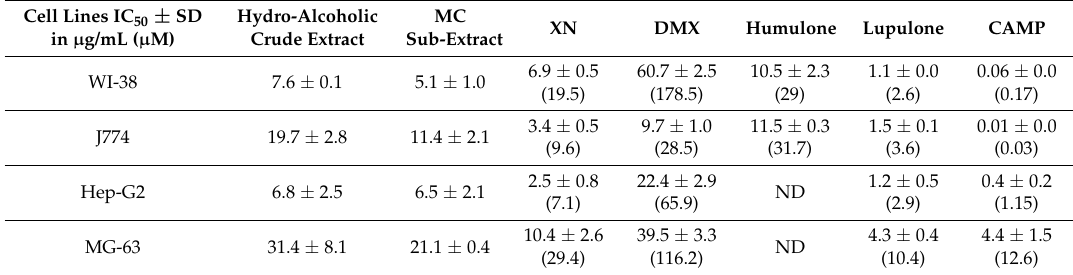
Table 7. Cytotoxic activities of hops extracts and isolated compounds (chalcones and acylphloroglucinols) against WI-38, J774, Hep-G2 and MG-63 cell lines. Cell Lines IC 50 ± SD in µ g/mL ( µ